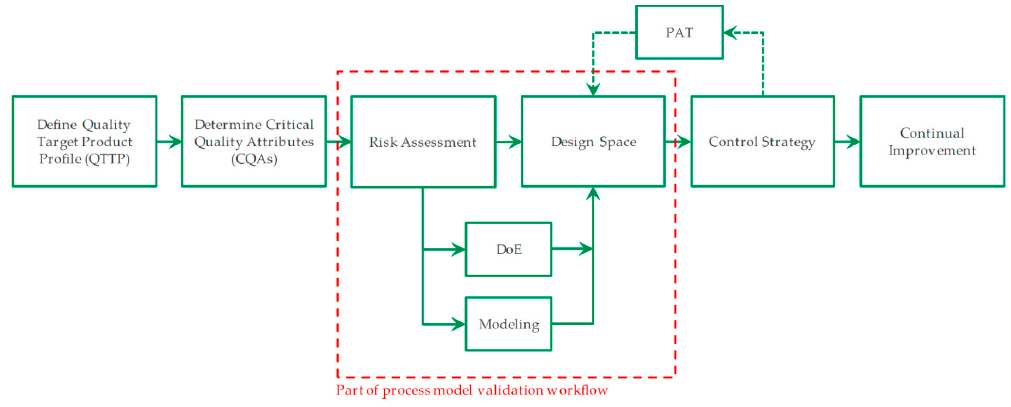
Figure 1. Quality-by-design (QbD) process development workflow with process modelling as its central part [17].